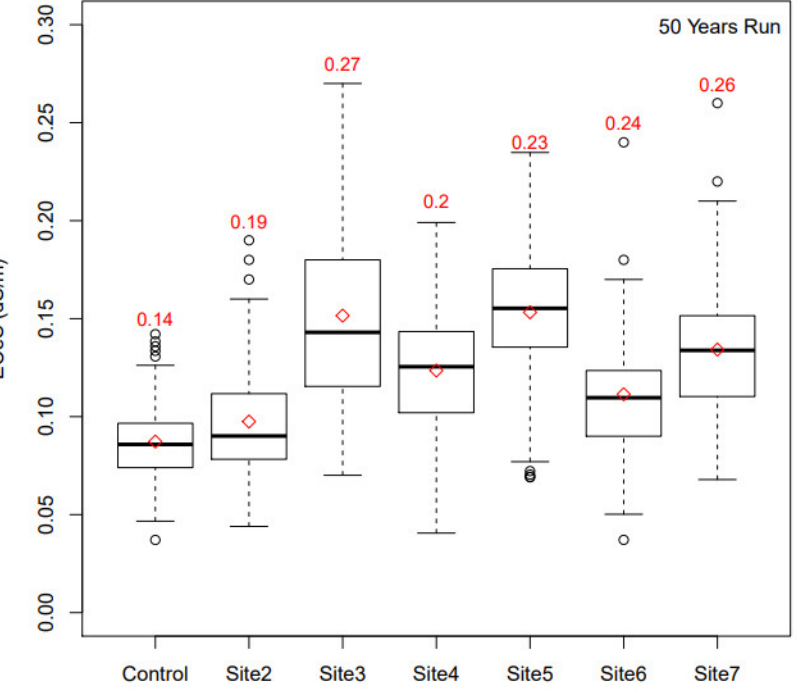
Figure 10. Range of estimated growing season saturated paste EC in the root zone for each site.